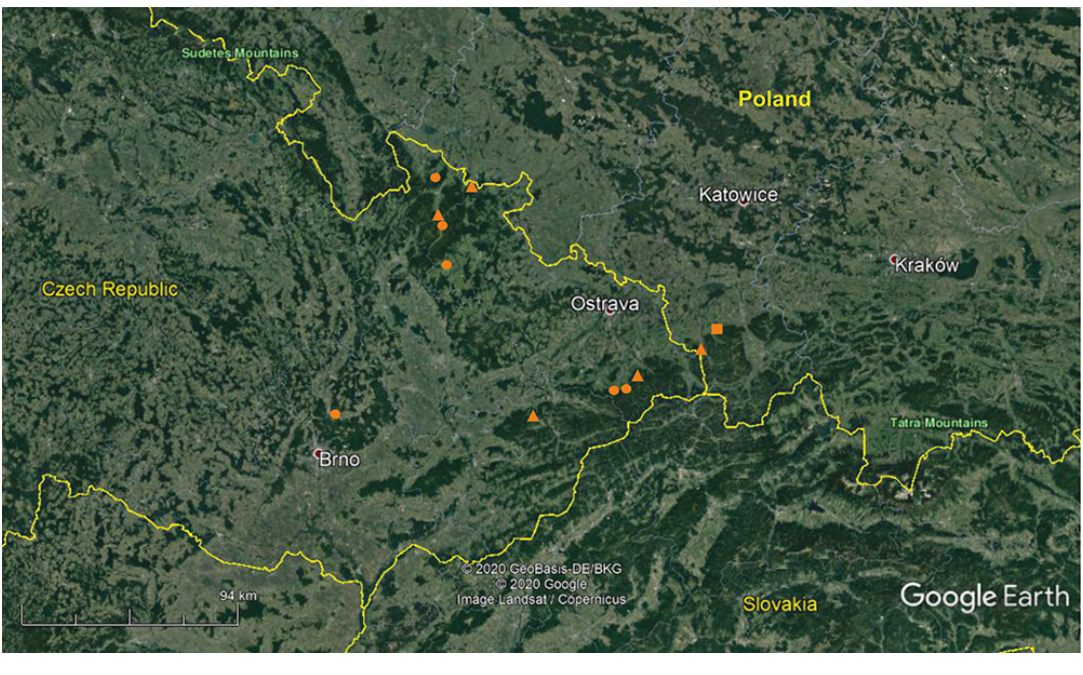
Table 1 Morphological and cytogenetic comparison of Polystichum setiferum and P. aculeatum . Character Polystichum setiferum Polystichum aculeatum Leaves Bright green, mat, feels so Deep green, glossy, feels stiff Truncate at base Tapering to base Petiole usually more than 1/6 leaf length Petiole usually less than 1/6 leaf length Pinnae Apex with distinct, protruding teeth Apex with indistinct, adherent teeth Pinnules Obtuse to acute angled base, stalked, hair-tipped Acute angled base, usually sessile, spiny-tipped e upper pinnula, nearest rachis, hardly longer or equal to the Considerably longer than the following following on the lowest pinnae Scales Bright brown on young plants, bright brown with dark brown Brown interior on adult plants Ploidy Diploid; 2 n = 82 Tetraploid; 2 n = 164 See Material and Methods for